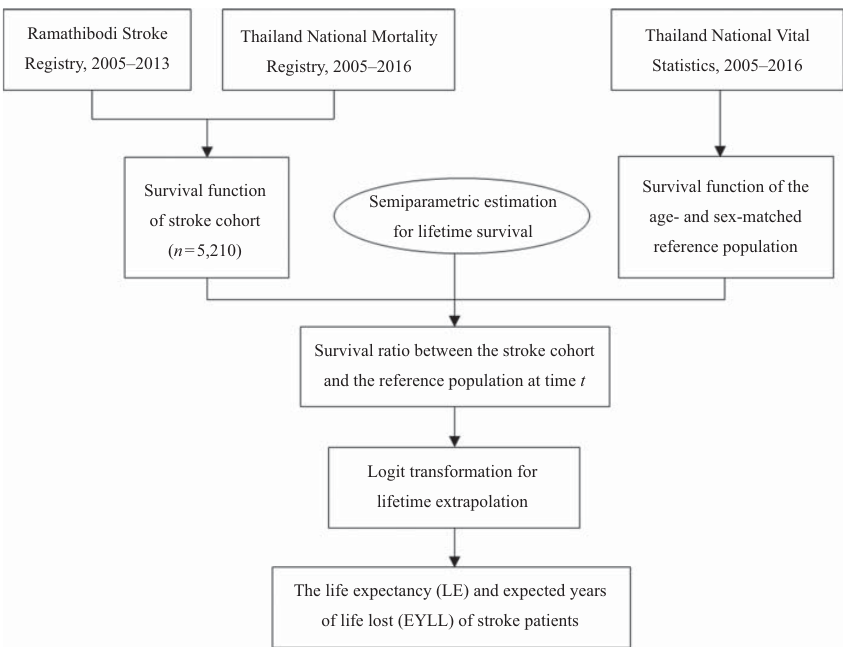
Figure 1. Flow diagram